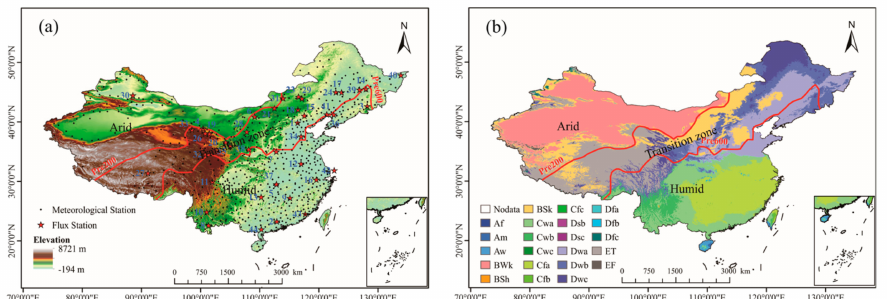
Figure 1. Locations of 693 meteorological stations (black solid dots), 44 flux stations (red stars), and the three sub-regions (i.e., arid region, transition zone, and humid region) ( a ), and the Köppen-Geiger climatic zones ( b